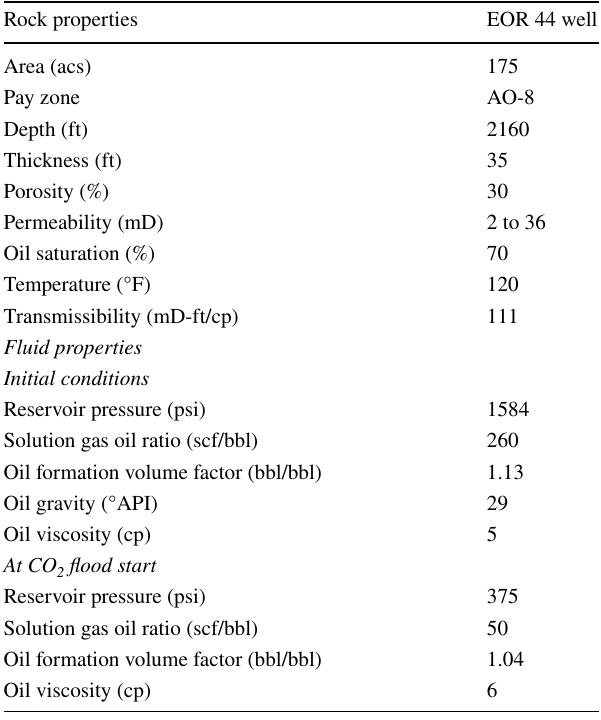
Table 1 Reservoir data for EOR 44 well, Oropouche (Mohammad- Singh and Singhal